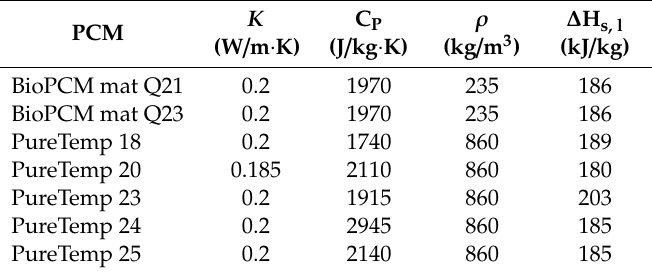
Table 6. Thermo-physical properties of various organic PCMs.